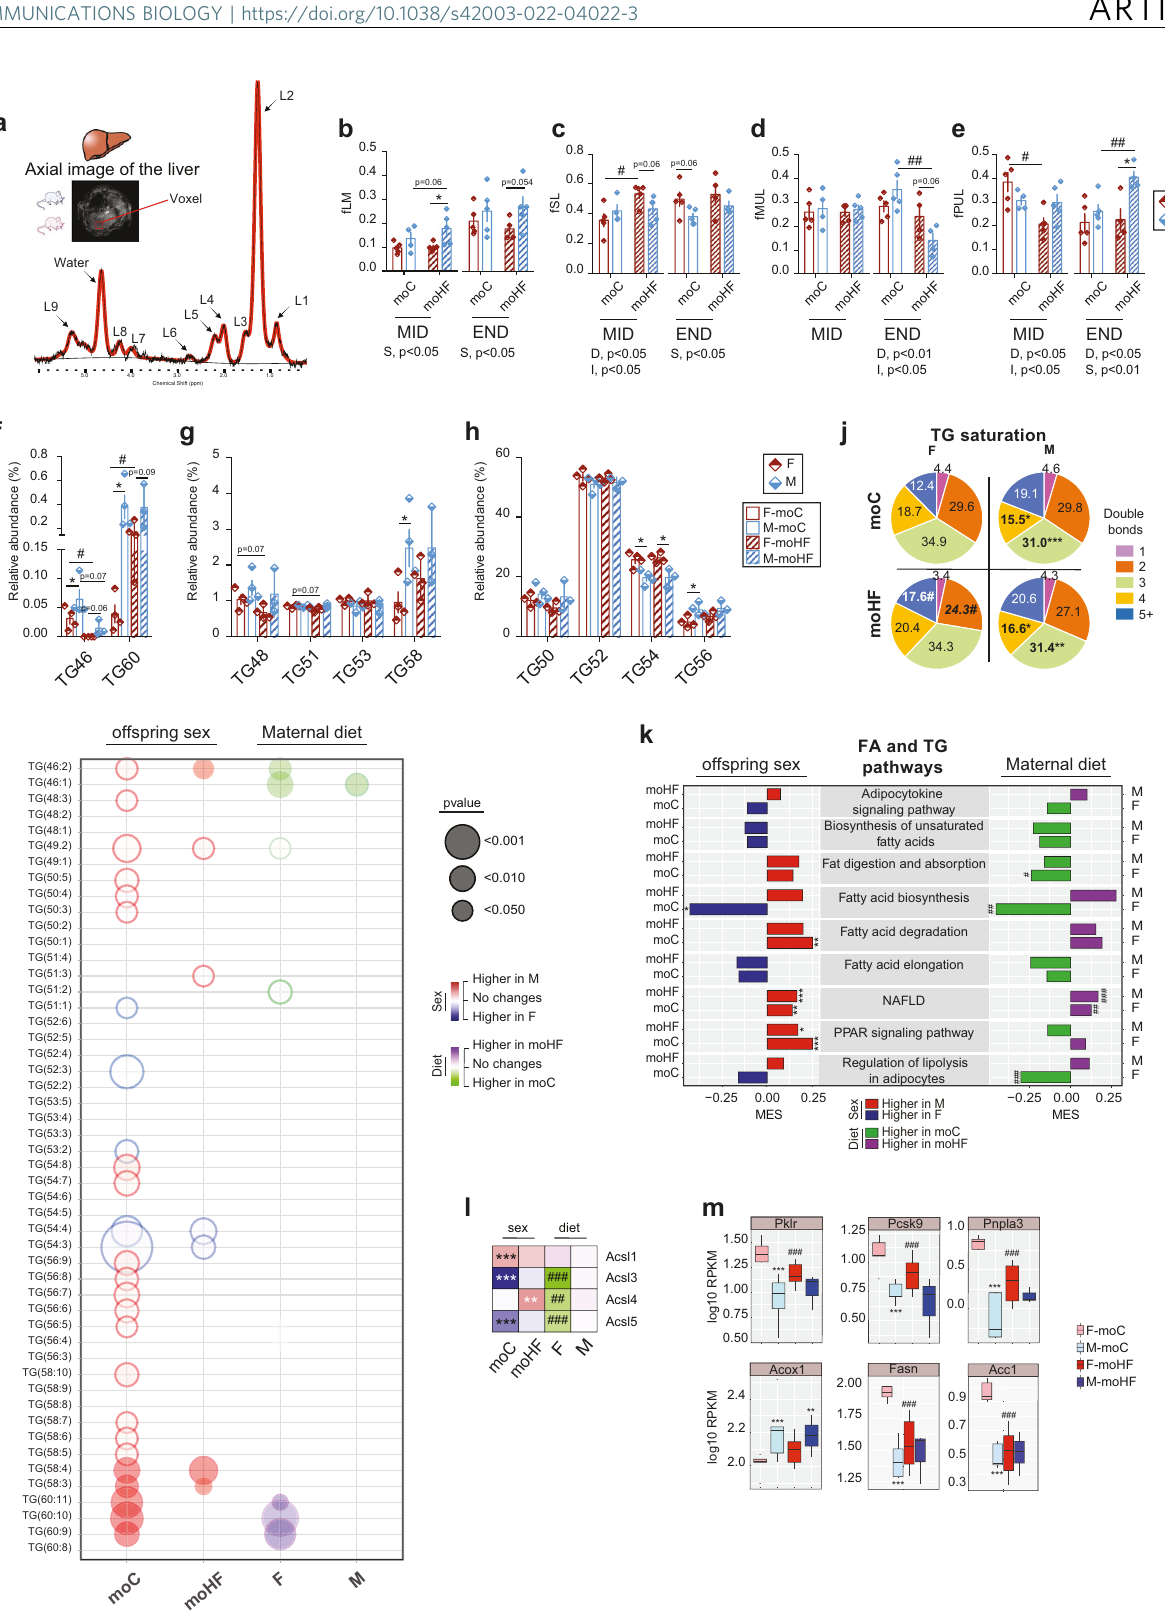
obesity. We found that fatty acids composition was sex- dependent whereby the abundance of the C20:0, C20:1 ω 9, C20:2 ω 9, and C20:3 ω 6 species was higher in males than females, irrespective of the maternal diet. MO increased the abundance of C18:2 ω 6 and reduced C16:0 species in females (Fig. S3a).